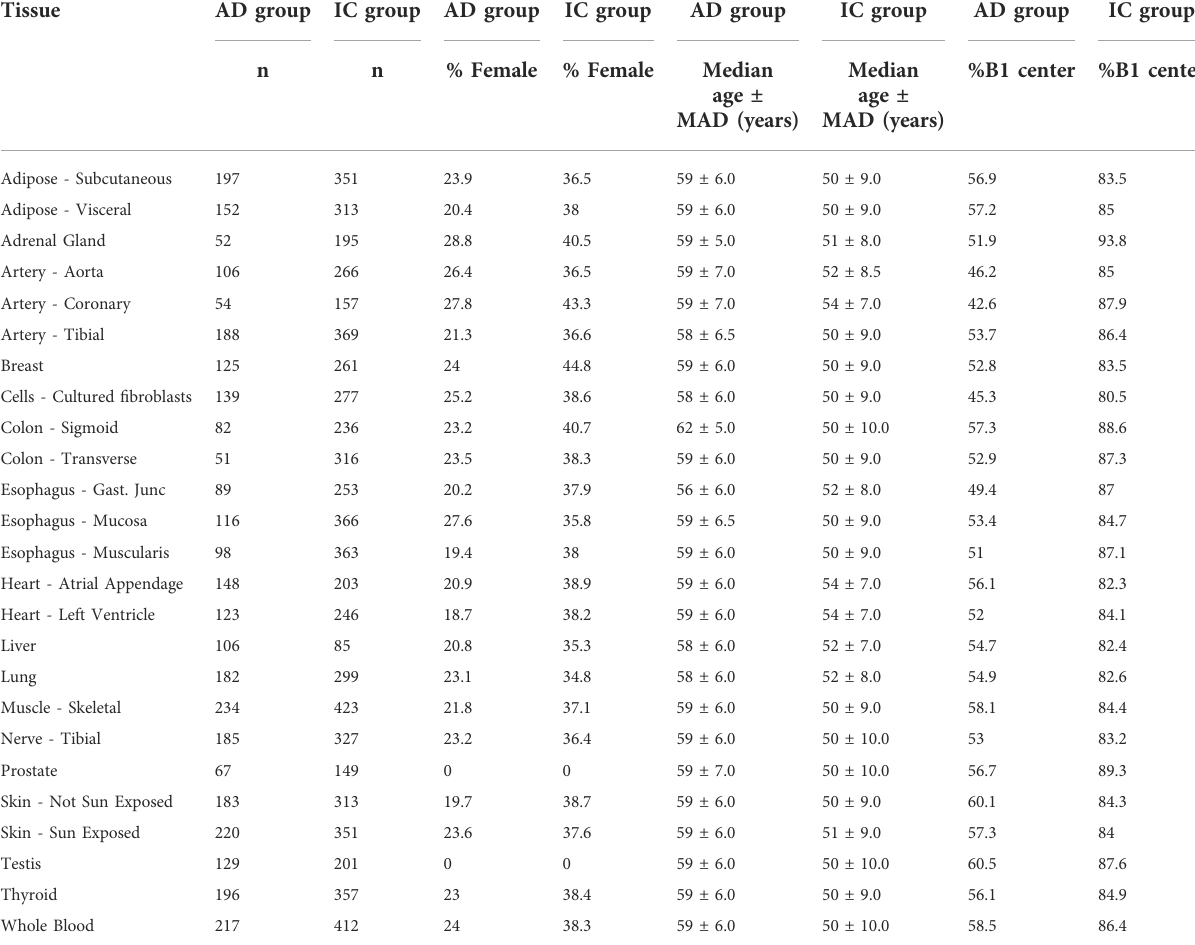
TABLE 1 Summary statistics of included subjects. AD and IC groups refers to Acute Death and Intensive Care groups, respectively. Samples collected from centers B1 and C1. MAD refers to the median absolute deviation of a variable from the median.